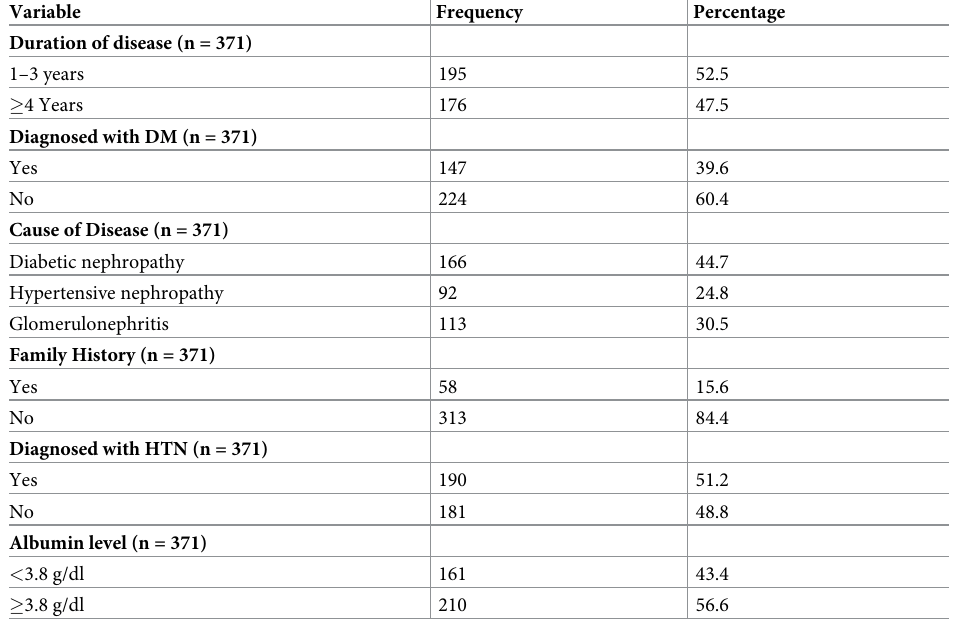
Table 4. Clinical conditions of chronic kidney disease patients in Saint Paulo’s and Zewditu Memorial Hospitals, Addis Ababa, Ethiopia, 2018.